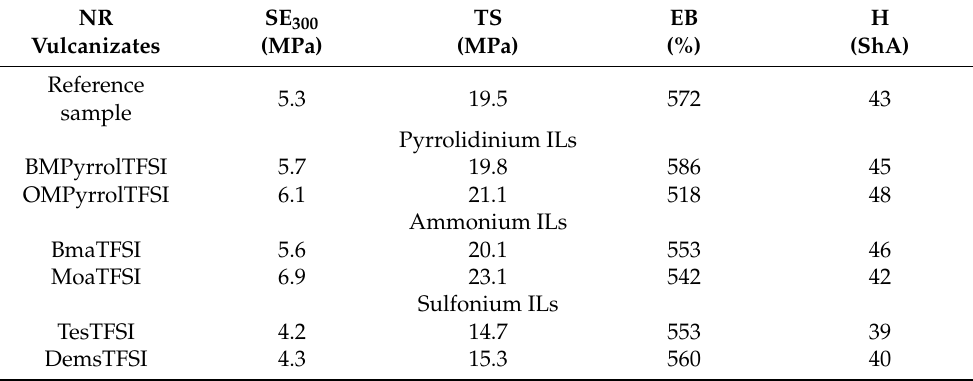
Table 7. Tensile properties and hardness of NR vulcanizates containing ILs with TFSI anion (SE 300 , stress at 300% relative elongation; TS, tensile strength; EB, elongation at break; H, hardness;